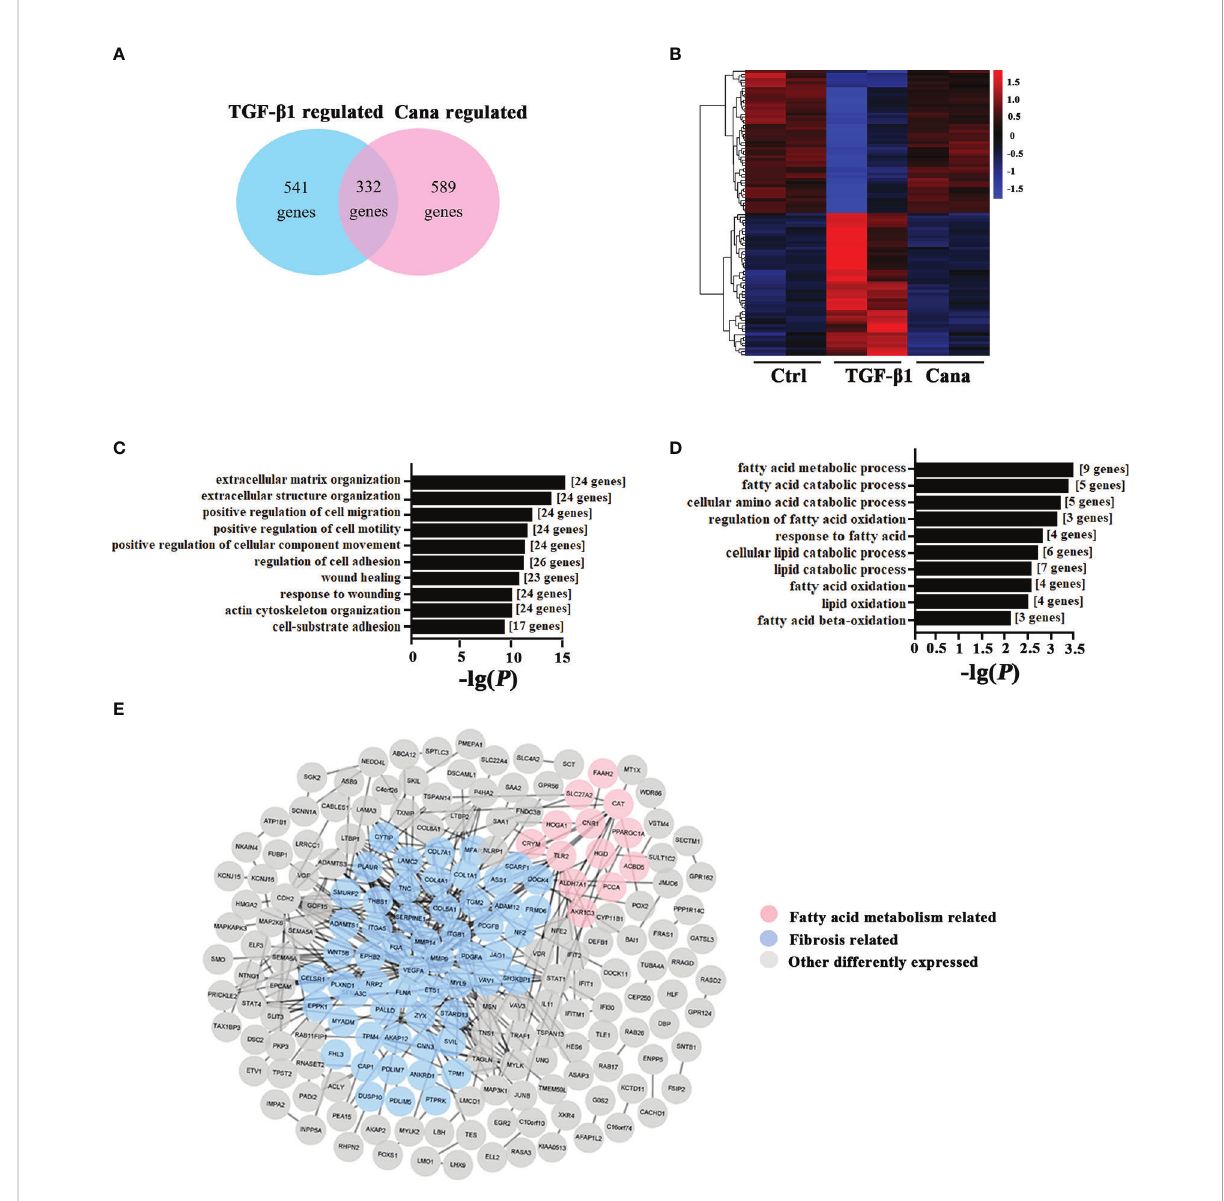
FIGURE 1 Cana positively regulated the abnormality of lipid metabolism and tubulointerstitial fi brosis. (A – E) The microarray expression dataset GSE118337 was retrieved from the GEO database. (A) A total of 541 genes were regulated by TGF- b 1, and 589 genes were by Cana ( p < 0.05, |log2FC| >1), with 332 genes at their intersection. (B) The heatmap displayed the top 50 upregulated and downregulated genes of two samples in the TGF- b 1 group and two samples in the Cana group by z-score, in comparison with the Ctrl group. GO analysis was separately conducted with genes upregulated by TGF- b 1 and downregulated by Cana (C) and genes downregulated by TGF- b 1 and upregulated by Cana (D) , and the 10 highest- ranking biological process terms are shown. (E) The interaction network of above 332 genes both regulated by TGF- b 1 and Cana, in which fi brosis-related genes and fatty acid metabolism-related genes according to enrichment results are